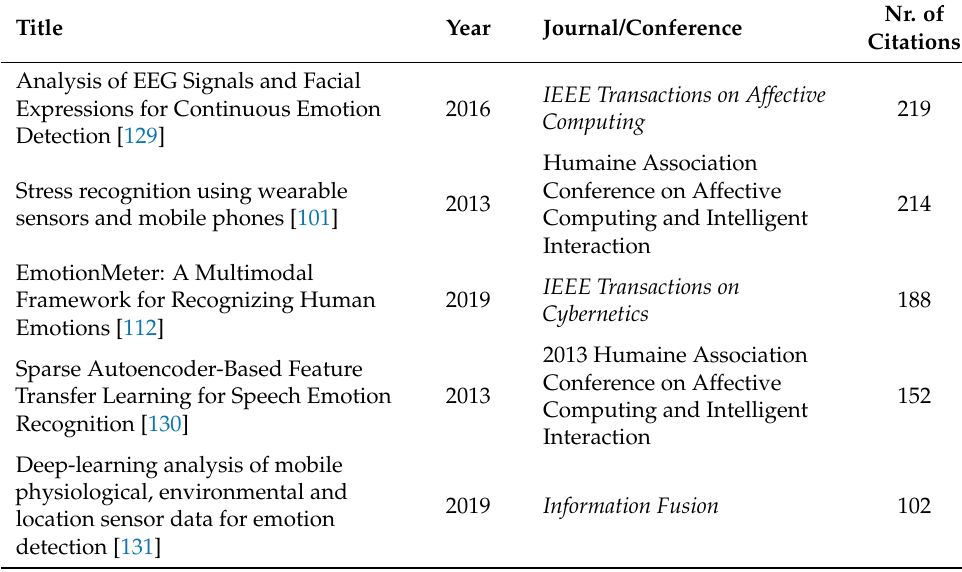
Table 7. Top ten most cited studies by the number of all paper